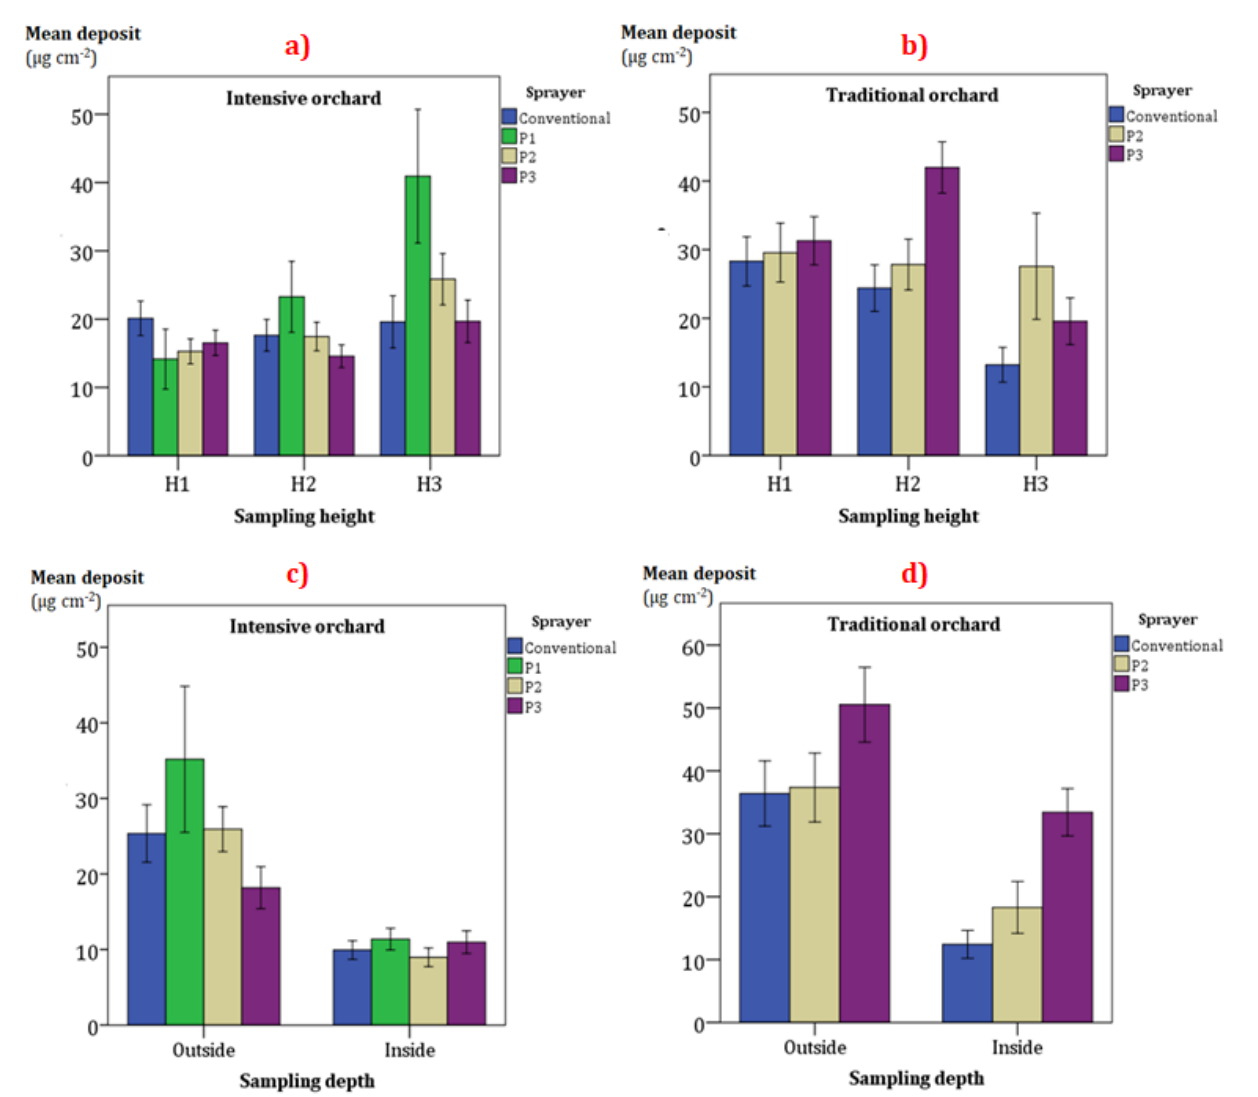
Figure 7. Mean deposit per sampling height for the tested sprayers in ( a ) the intensive orchard and ( b ) for the traditional orchard. Mean deposit per sampling depth for the tested sprayers ( c ) the intensive orchard and ( d ) for the traditional orchard. Whiskers represent the standard error.